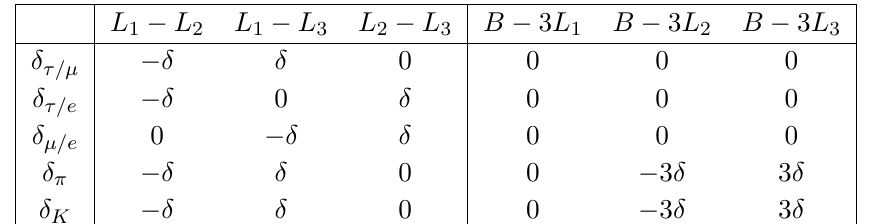
(cid:17) ( g ‘ =g ‘ 0 ) (cid:0) 1 and (cid:14) (cid:25);K (cid:17) ( g (cid:28) =g (cid:22) ) (cid:25);K (cid:0) 1. ‘=‘ 0